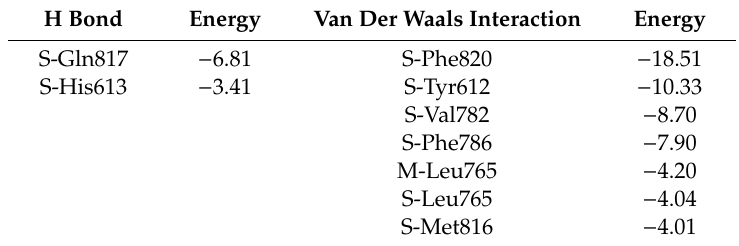
Table 5. The energy of the main interactions between protein PDE5 residue and ligand 3g.